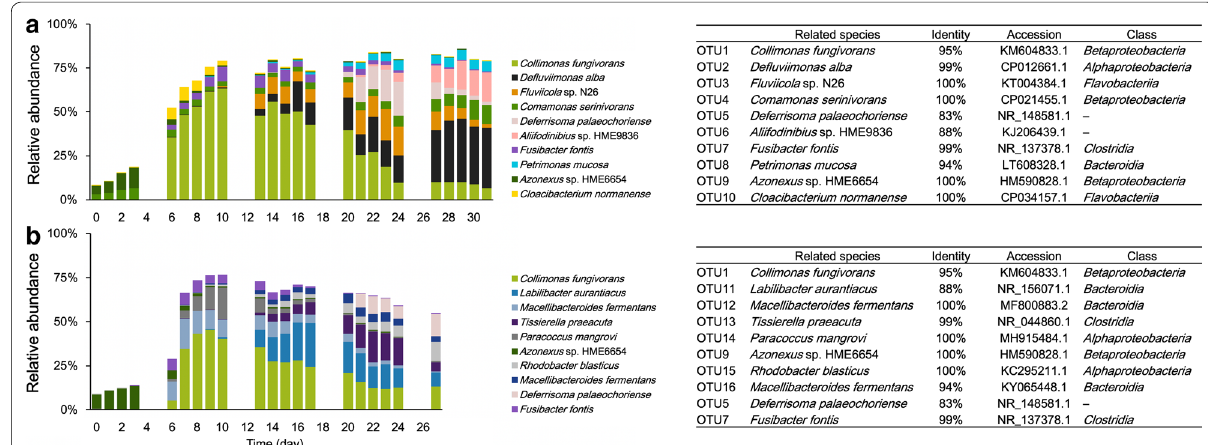
Fig. 4 Transition of the 10 most dominant operational taxonomic units (OTUs) throughout the operation. Microbial community structures and phylogenetic information in Reactors 1 ( a ) and 2 ( b ). The phylogenetic information of each OTU is shown in the table on the right. The related species of the OTUs were assigned using a BLAST analysis (https ://blast .ncbi.nlm.nih.gov/Blast .cgi) and the phylogenetic categories at a class level were assigned using QIIME software